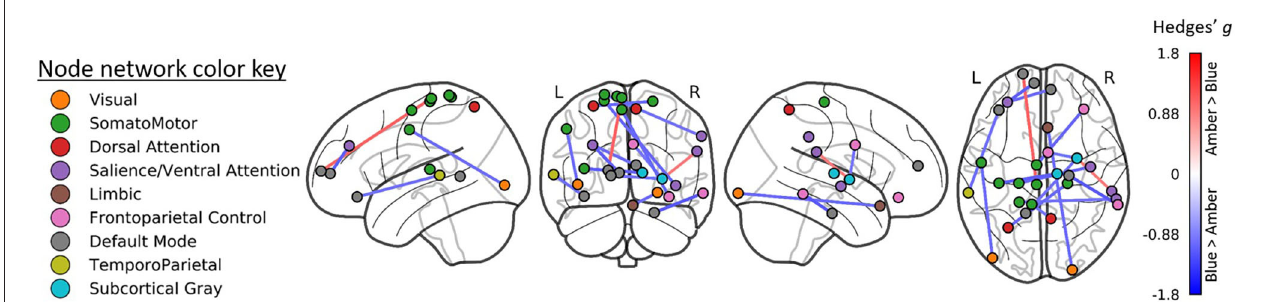
FIGURE 2 | Region-to-region functional connectivity differences following treatment. Blue light treatment was associated with greater functional connectivity in 14 ROI-to-ROI connections linking the visual, default mode, somatomotor, and dorsal attention networks (all FDR p < 0.01).